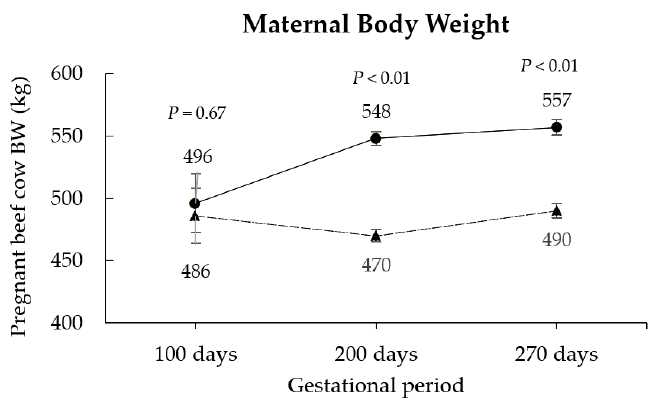
Figure 1. Effects of maternal protein supplementation on pregnant beef cow body weight (kg). RES (unsupplemented cows at mid-gestation, n = 24); CON (cows supplemented with protein at mid- gestation, n = 19). The symbols represent the average data from CON (●) and RES ( ▲ ) groups.